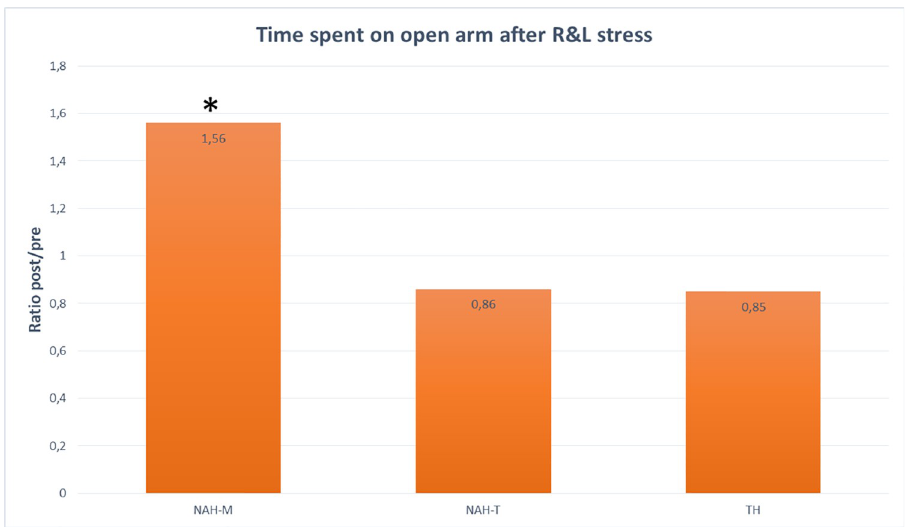
Fig 7. EPM test. Time spent on open arm after R&L stress expressed as ratio of post/pre-stress. Mice treated with NAH-M spent a significantly longer time on open arm after stress, (H value of Kruskal Wallis = 6,458, p = 0,0396, Eta 2 = 18%.) suggesting a beneficial effect on anxiety in this experimental group.